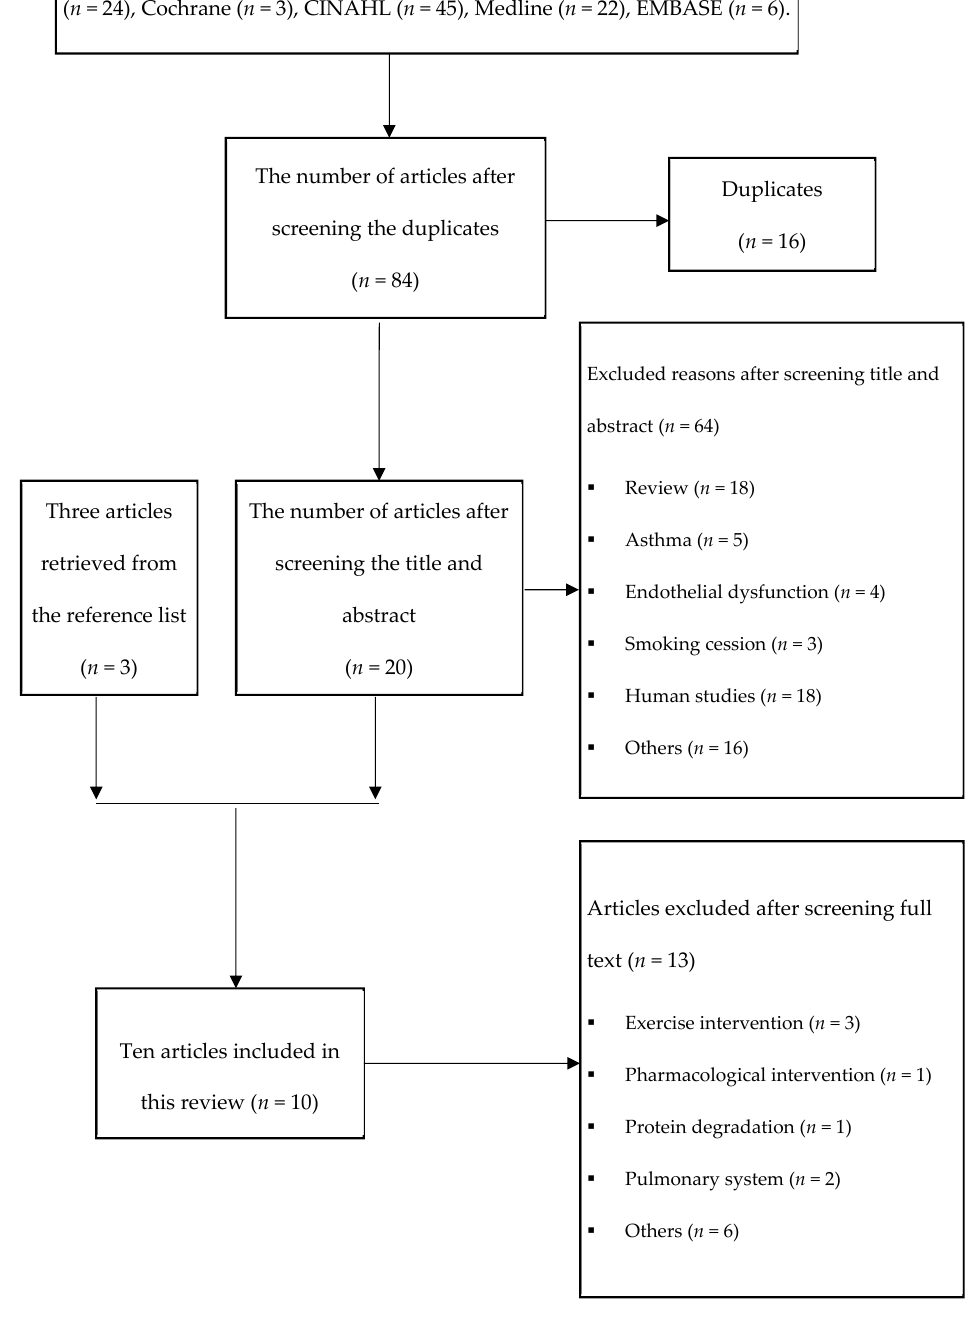
Figure 1. Selection procedure for